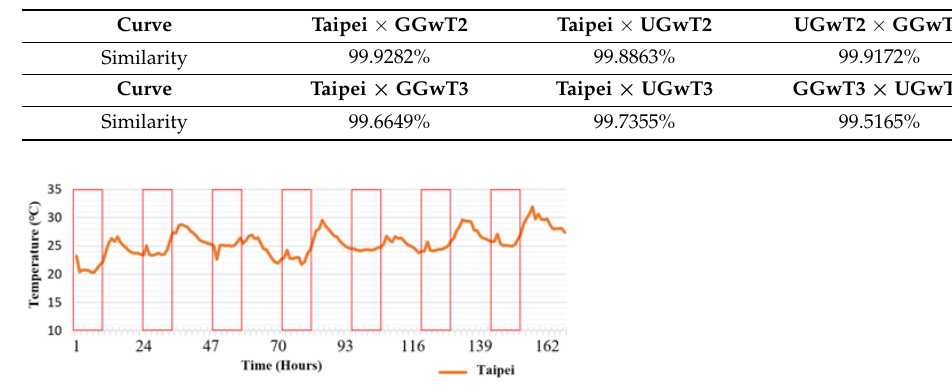
( d ) Figure 6. Temperature and humidity of permeable brick pavement ( a ) Region C, ( b ) Region D, ( c ) temperature reduction effect in Region C, and ( d ) temperature reduction effect in Region D. Table 10. Regions C and D: Similarities between permeable brick pavements. Curve Taipei × GGwT2 Taipei × UGwT2